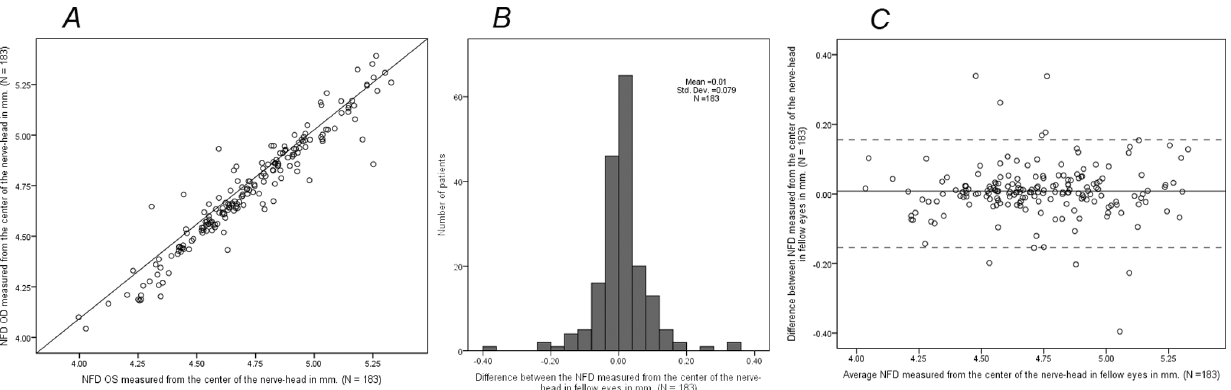
Figure 3. A. NFD measured from the center of the nerve-head of the right eye (OD) plotted against this measurement of the left eye (OS) together with the line of equation (N=183). B. The distribution of differences between the NFDs measured in fellow eyes from the center of the nerve-head (N=183). C. The difference between NFDs against NFD averaged over both eyes measured from the center of the nerve-head between fellow eyes. The solid line indicates the mean and the dotted lines the 95% limits of agreement (N=183).